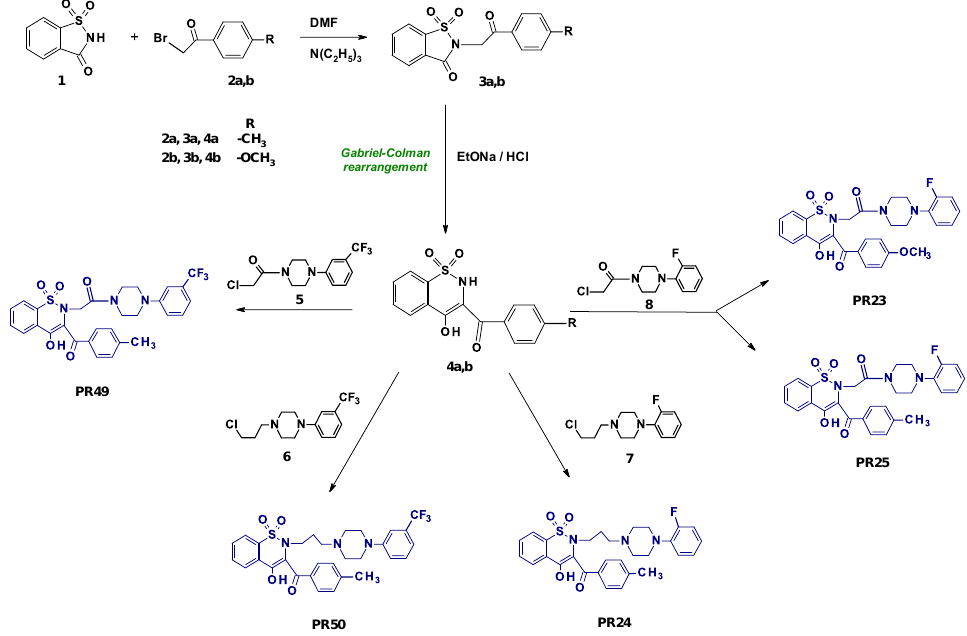
Figure 1. Chemical structure of meloxicam and its new analogues with the same 1,2-benzothiazine scaffold.